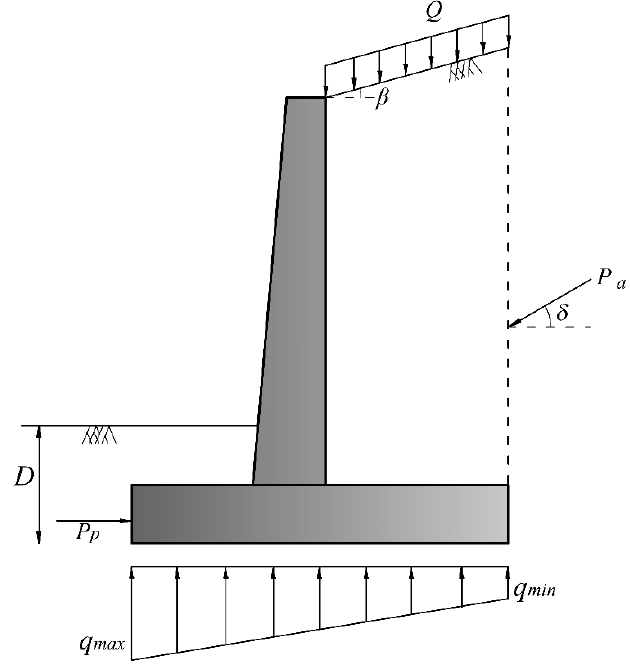
Figure 6. Forces acting on the retaining wall.